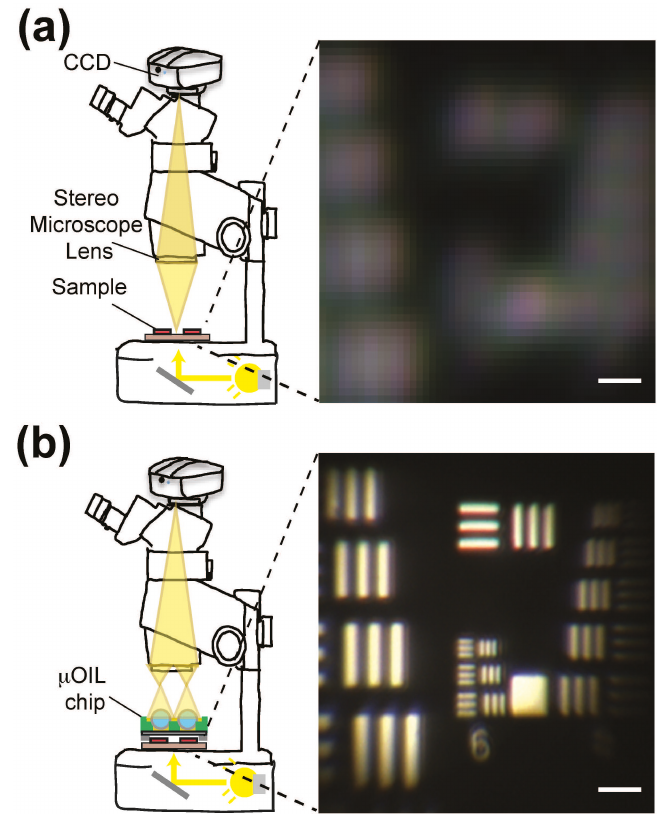
Figure 6. Images of a resolution plate (USAF1951) obtained from a stereo microscope alone ( a ) and from the combined µOIL chip/stereo microscope system ( b ). Scale bar: 10 µm in ( a ) and ( b ).